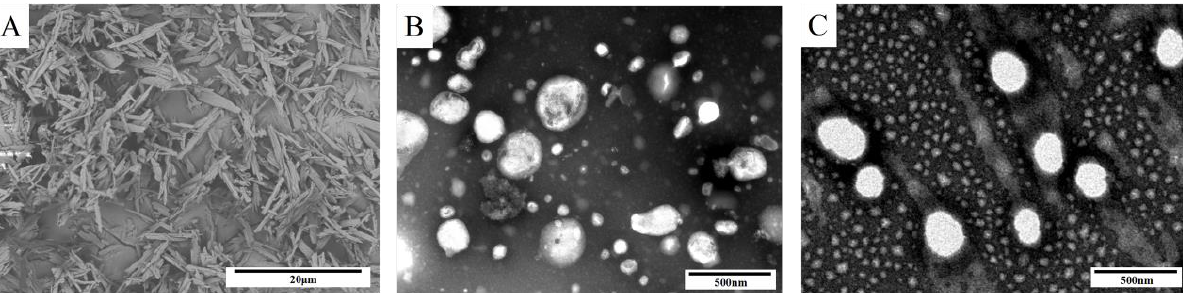
Figure 4. Microscopic observation.The SEM of Bre ( A ). Note: scale bar = 20 μm. The TEM of Bre -NS ( B ) and Bre-NS freeze-dried powder ( C ). Note: scale bar = 500 nm.